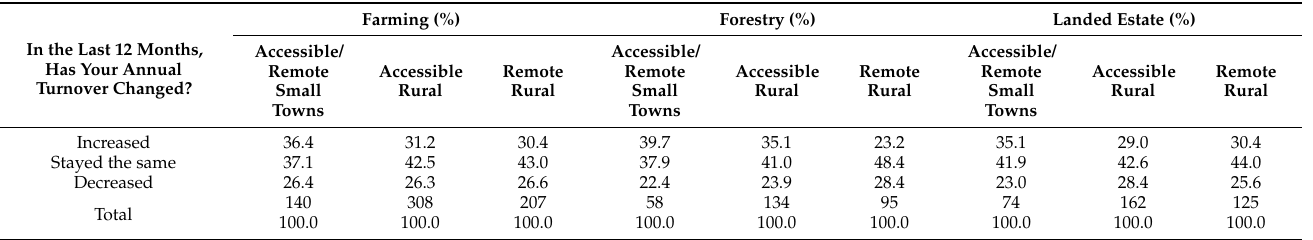
Table 5. Comparative analysis of turnover changes among non-land-based businesses in different rural town